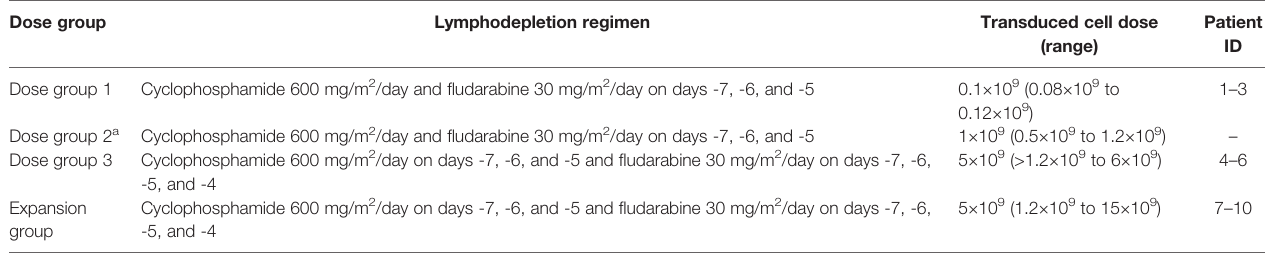
TABLE 1 | Dose groups – lymphodepletion and cell doses. Dose